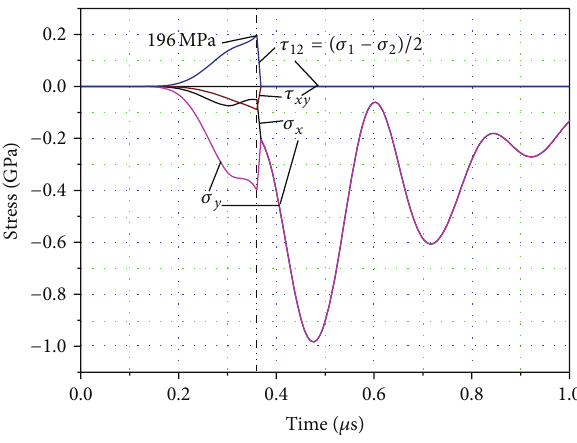
Figure 5: Stresses change of the element containing point